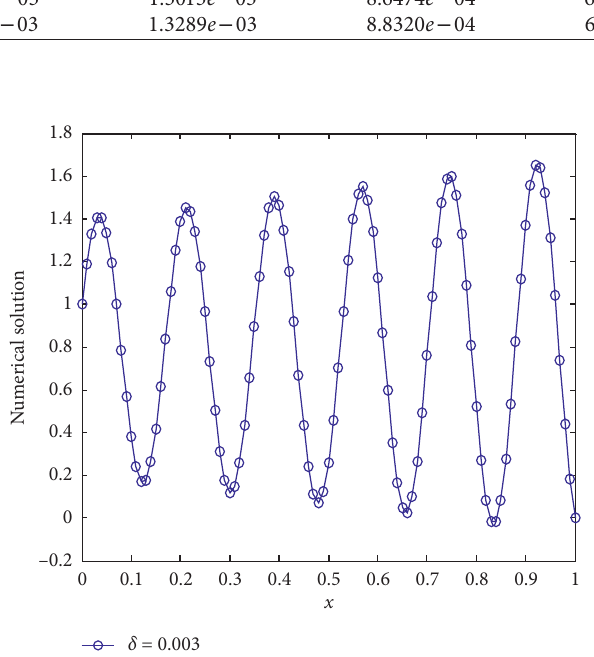
Figure 3: The numerical solution of Example 3 with ε � 0 . 001 and N � 100.